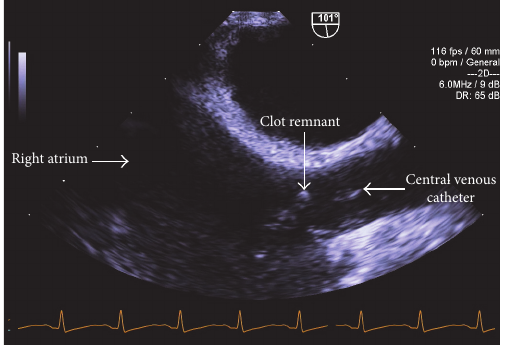
Figure 5: Neohepatic phase. TEE midesophageal bicaval view (depth decreased to 6cm): significant reduction in clot